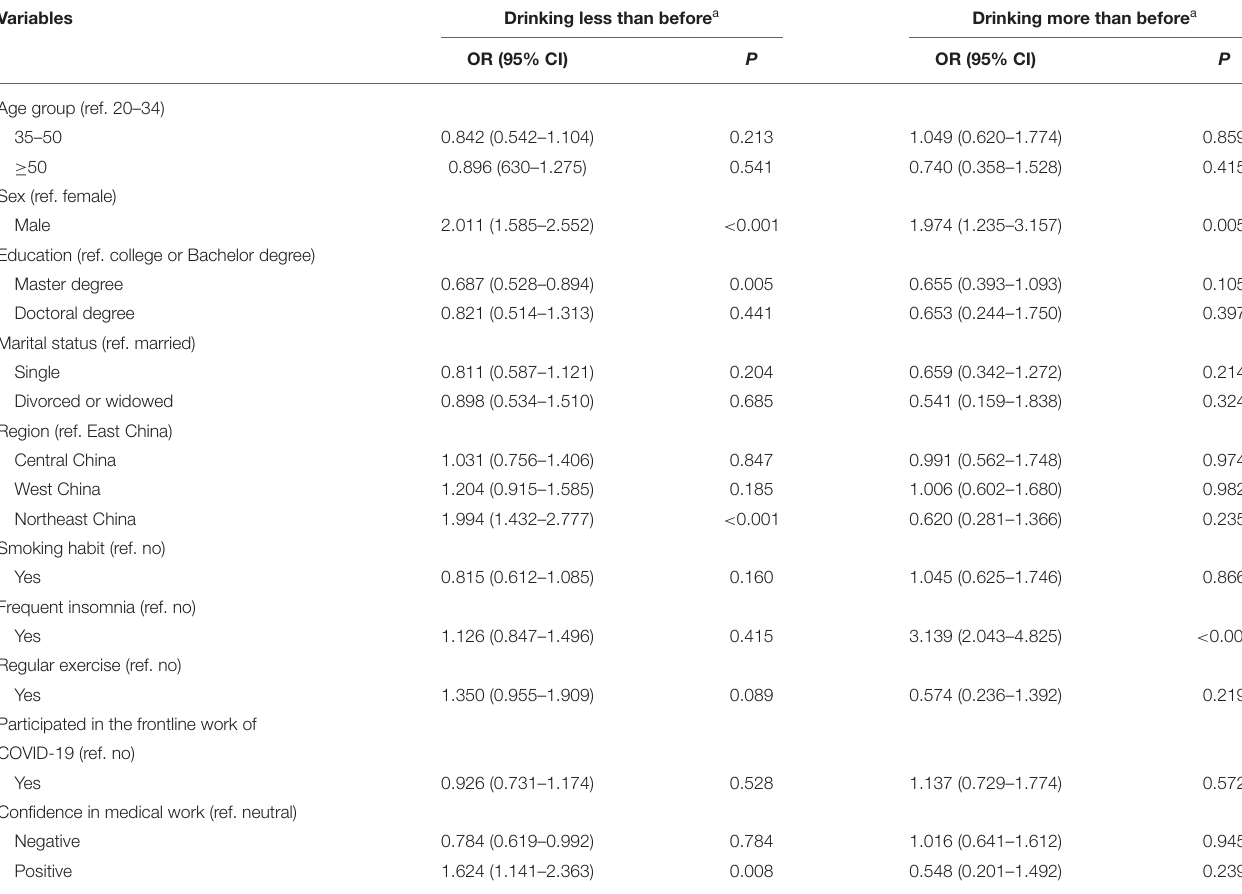
TABLE 4 | Multiple logistic regression examining individual characteristics associated with alcohol use changed.